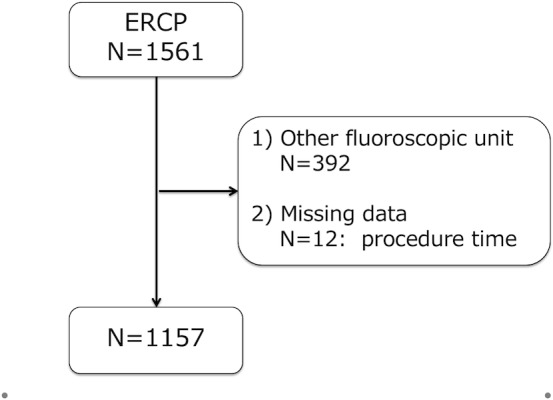
Study flow chart.